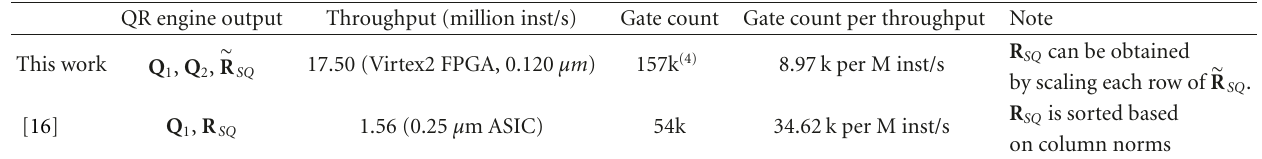
Table 9: QR decomposition engine comparison.